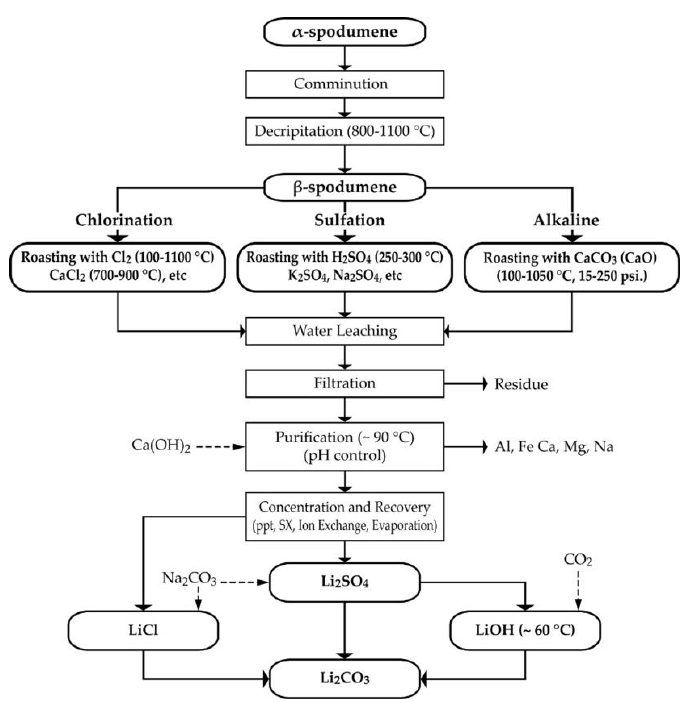
Figure 1. The flow diagram of the major treatment processes for spodumene (chlorination, sulfation and alkaline processes).